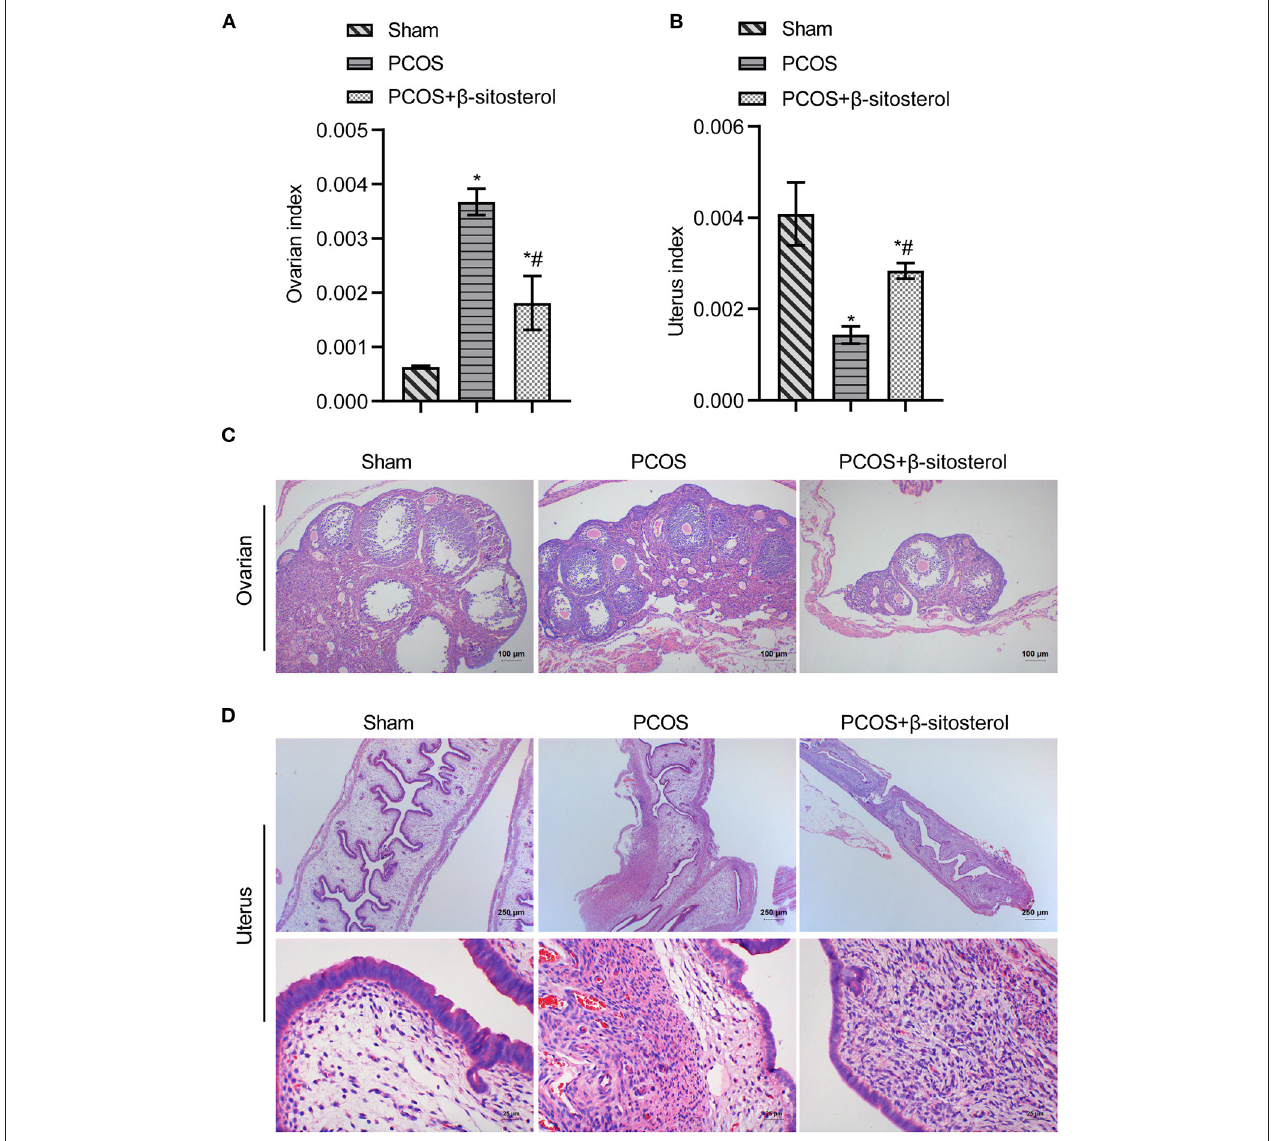
FIGURE 1 | Effect of β -sitosterol on ovaries and uterus in PCOS-like mice. (A) Ovarian index. (B) Uterine index. (C) Hematoxylin and eosin (H&E) staining was performed to observe pathological changes of ovarian tissue in each group (magnification, 100 × ; scale bar = 100 µ m). (D) H&E staining showed pathological changes of uterine tissue in each group. Upper images are magnified 40-fold (scale bar = 250 µ m), and local magnification (underneath) is magnified 400-fold (Scale bar = 25 µ m). Data are presented as mean ± SEM. * P < 0.05 vs. Sham. # P < 0.05 vs. PCOS. PCOS, polycystic ovary